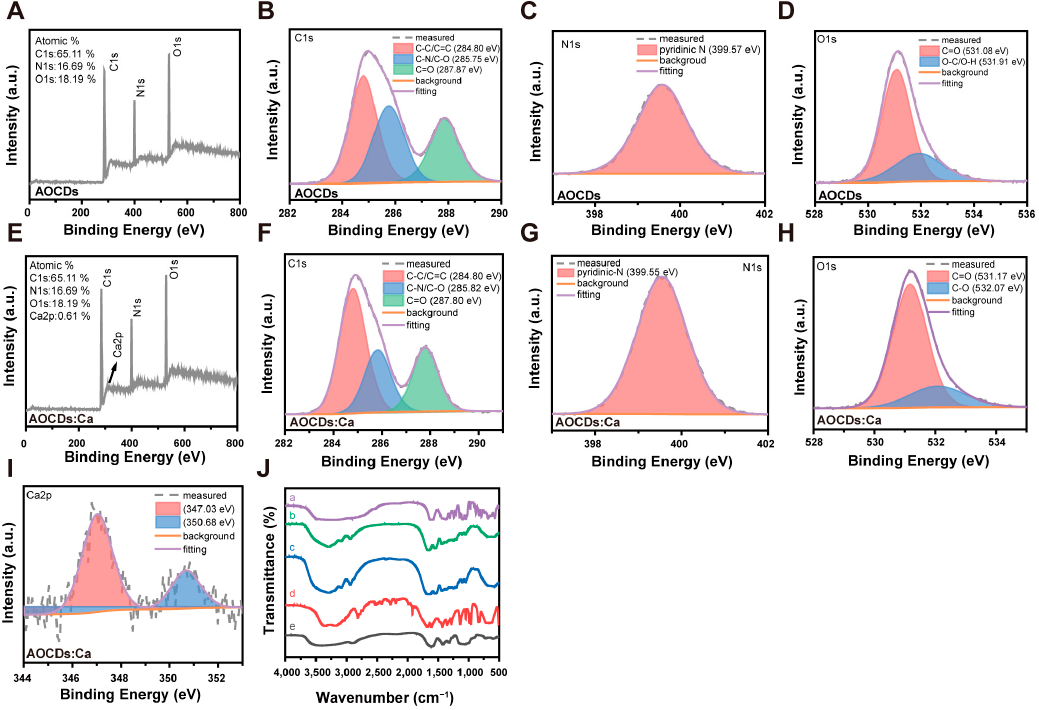
Figure 3. Structural analysis of CDs. XPS analyzed the structure of AOCDs ( A ). Element